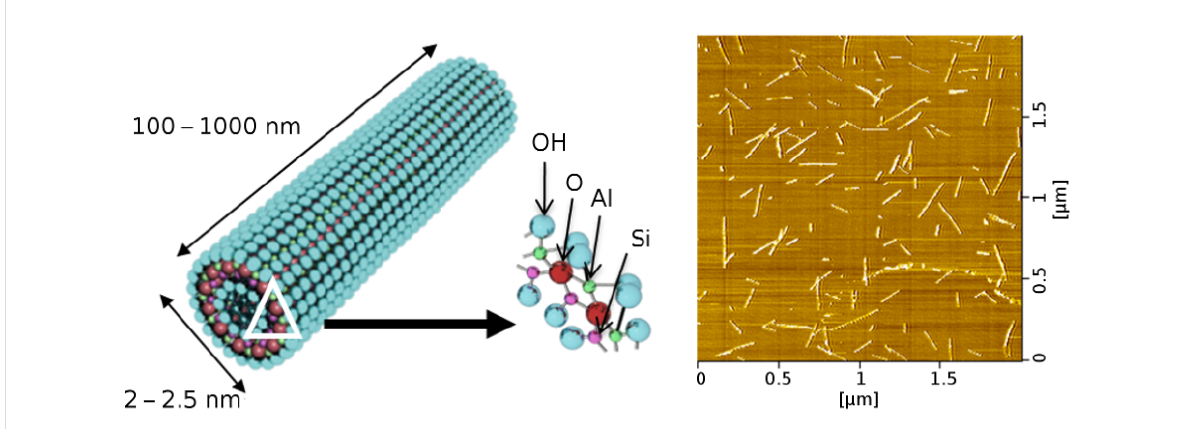
Figure 1: Schematic illustration of imogolite-nanotube structure (left). DFM image of imogolite (right).